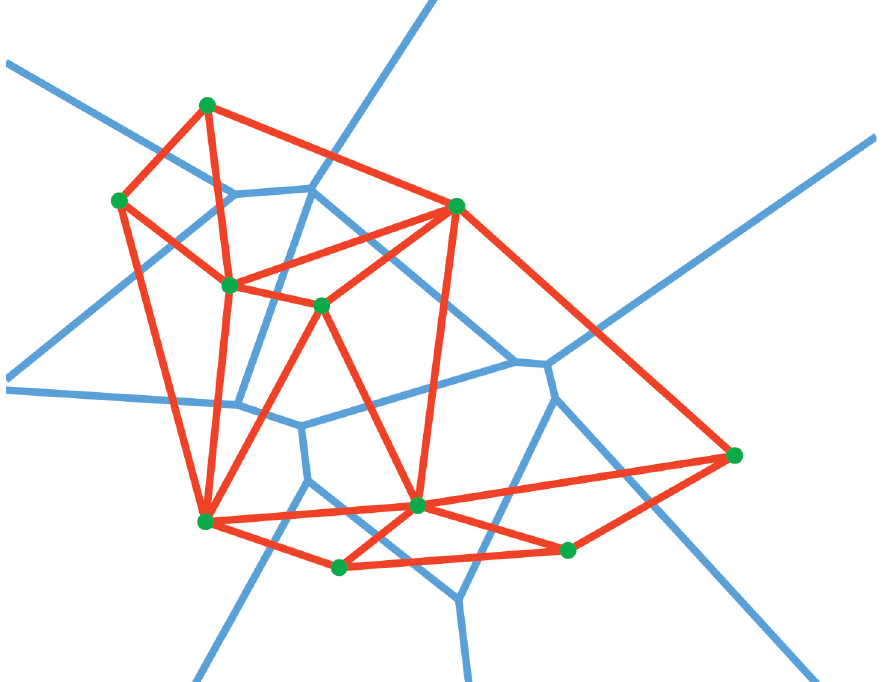
Fig 1. Sketch of a Delaunay Triangulation. The Delaunay triangulation and its dual, the Voronoi tessellation for a random set of points. The blue lines are the segments of the Voronoi tessellation, the red ones are the edges of the Delaunay graph